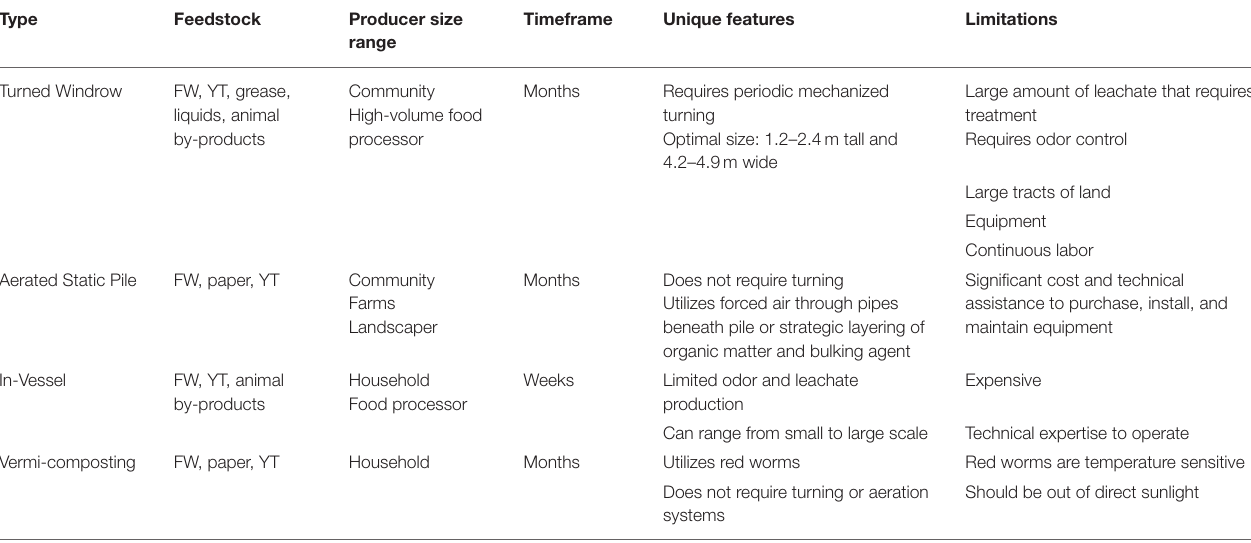
TABLE 4 | Categories of composting methods for food